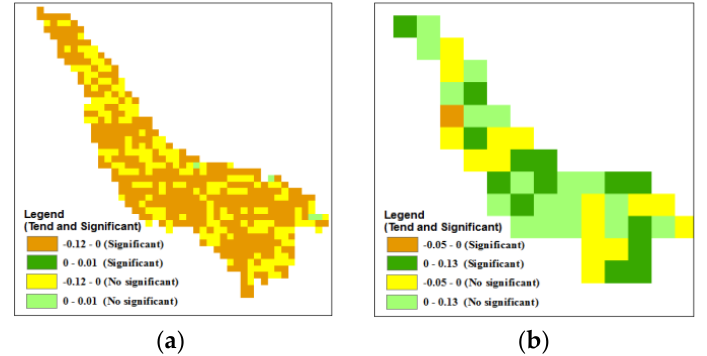
11 of 5 Figure 8. Comparison between simulated and satellite annual maximum LAI. In order to quantify land cover change in detail, satellite observed LAI was used to reflect actual land cover change caused by combination of climate change and human activities, and simulated potential LAI by an ecological model representing climate ‐ induced land cover change. The difference between the two was considered the true impacts from human ‐ induced land cover change. Thus, the linear trend of annual LAI from GIMMS and potential LAI from the Biome ‐ BGC model forced by real climate data alone were further calculated to identify these complex land cover changes (Figure 9), which expressed some inverse trend between actual LAI and potential LAI from 1982 to 2006. Almost all of the area in the basin showed a decreasing trend for the actual LAI whereas most grids had an increasing trend for potential LAI. On the other hand, the maximum decreasing trend of actual LAI is 0.12, much higher than the increasing slope of 0.01, and the maximum increasing trend of potential LAI is 0.13, much higher than the decreasing slope of 0.05. This unsymmetrical result also showed that human actives aversely changed the trend of land cover. To quantify this type of land cover change, LAI were then standardized according to the Equation (12). Results showed that the average standardized potential LAI ( M LAIp ) was larger than